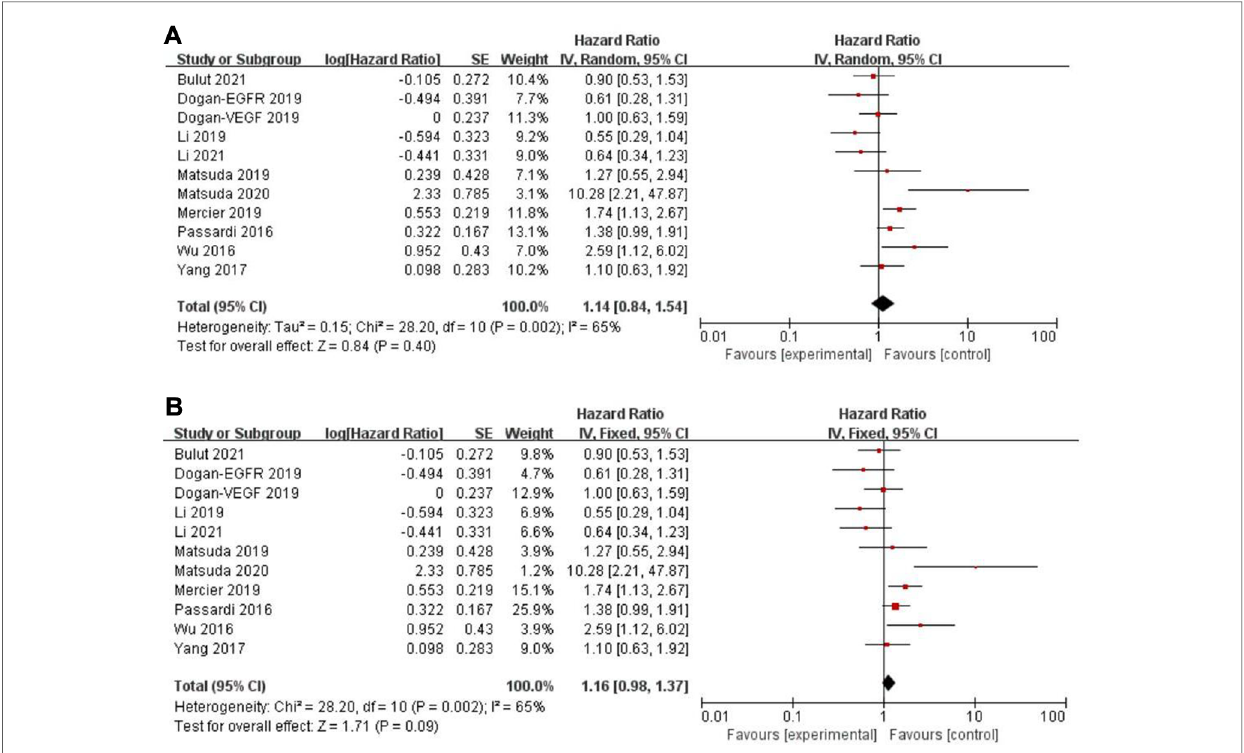
FIGURE 5 Forest graph on association of progression-free survival with different levels of platelet-to-lymphocyte ratio groups. ( A ) random effect model. ( B ) fi xed effect model.